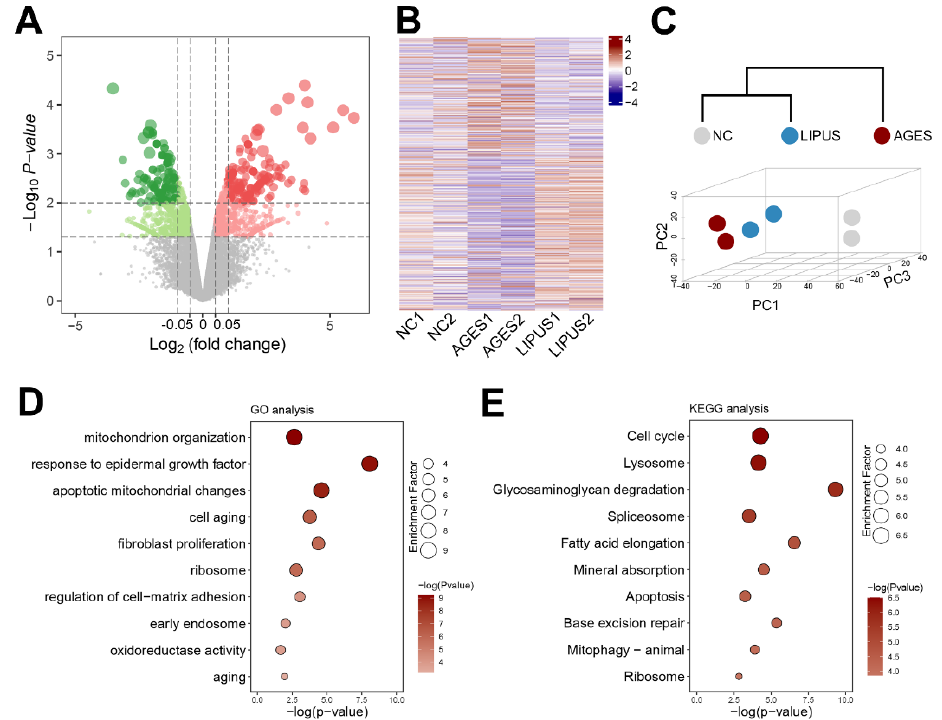
Figure 5. The transcriptome changes of CCECs after LIPUS treatment. ( A ) Volcano plot showing the DEGs between CCECs treated with AGES and negative controls by RNA sequencing. A gradient of green to red indicates the down-regulation to up-regulation of the genes. ( B ) Heatmap shows the expression level of DEGs among NC, AGES treatment, and AGES with LIPUS treatment groups. A gradient of blue to red indicates the down-regulation to up-regulation of the genes. ( C ) PCA 3D mapping plot and cluster analysis dendrogram of CCEC samples in each group. ( D , E ) Bubble diagram of the enriched GO ( D ) or KEGG ( E ) of CCECs. A gradient of light gray to red indicates inhibition to activation of the term. The size of the bubble indicates the p -value from high to low. NC: negative control (0 µ g/mL AGES and 0 mW/cm 2 LIPUS); AGES: advanced glycation end products (100 µ g/mL)-treated group; LIPUS: low-intensity pulsed ultrasound and 100 µ g/mL AGES-treated group.